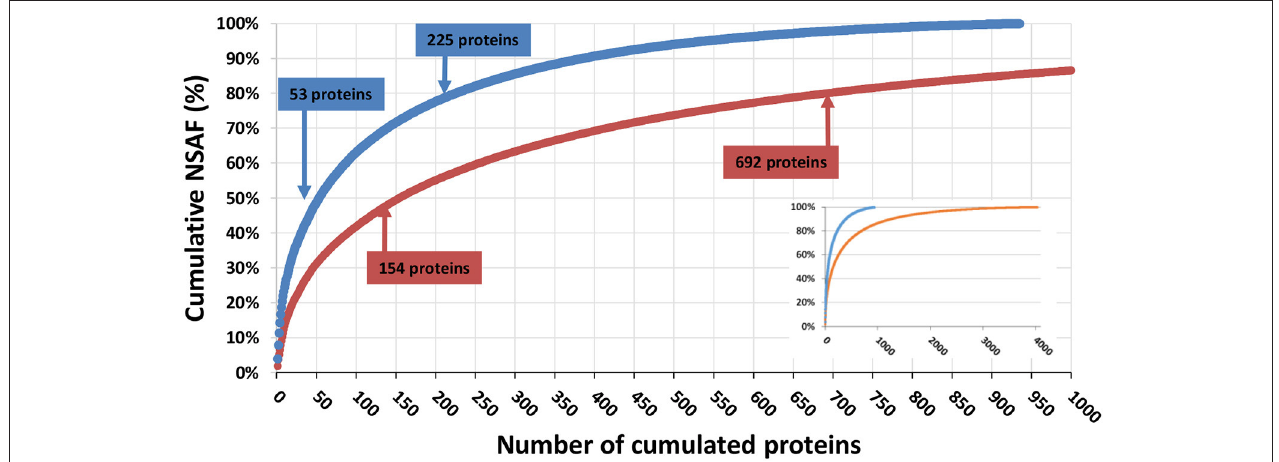
FIGURE 3 | Saturation curve for number of proteins identified . Proteins detected by the Q Exactive HF (orange) or LTQ Orbitrap XL (blue) were ranked from the most to the least abundant (x axis). Their cumulated abundance, as determined based on their NSAF, is represented in terms of percentage of the overall proteome (y axis). The inset presents the same figure with a fully extended x